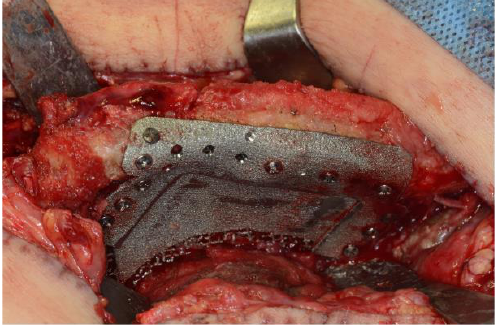
Figure 8. Applied 3D-printed titanium implant for iliac crest reconstruction.